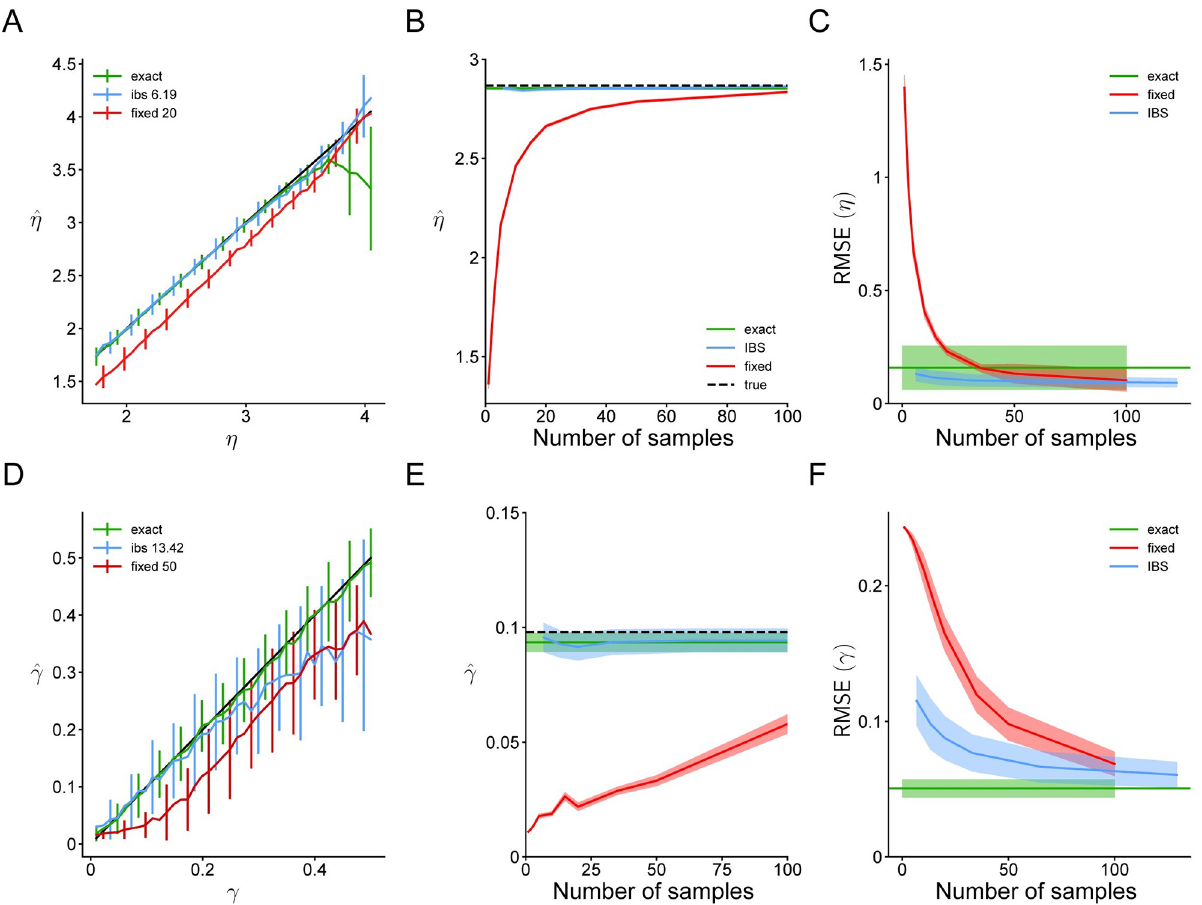
Fig 7. Parameter recovery for the change localization model. Same as Fig 5, for the change localization experiment and estimates of η � log σ and γ . In panel A we show results for R = 1 and M = 20; in panel D , R = 2 and M = 50.